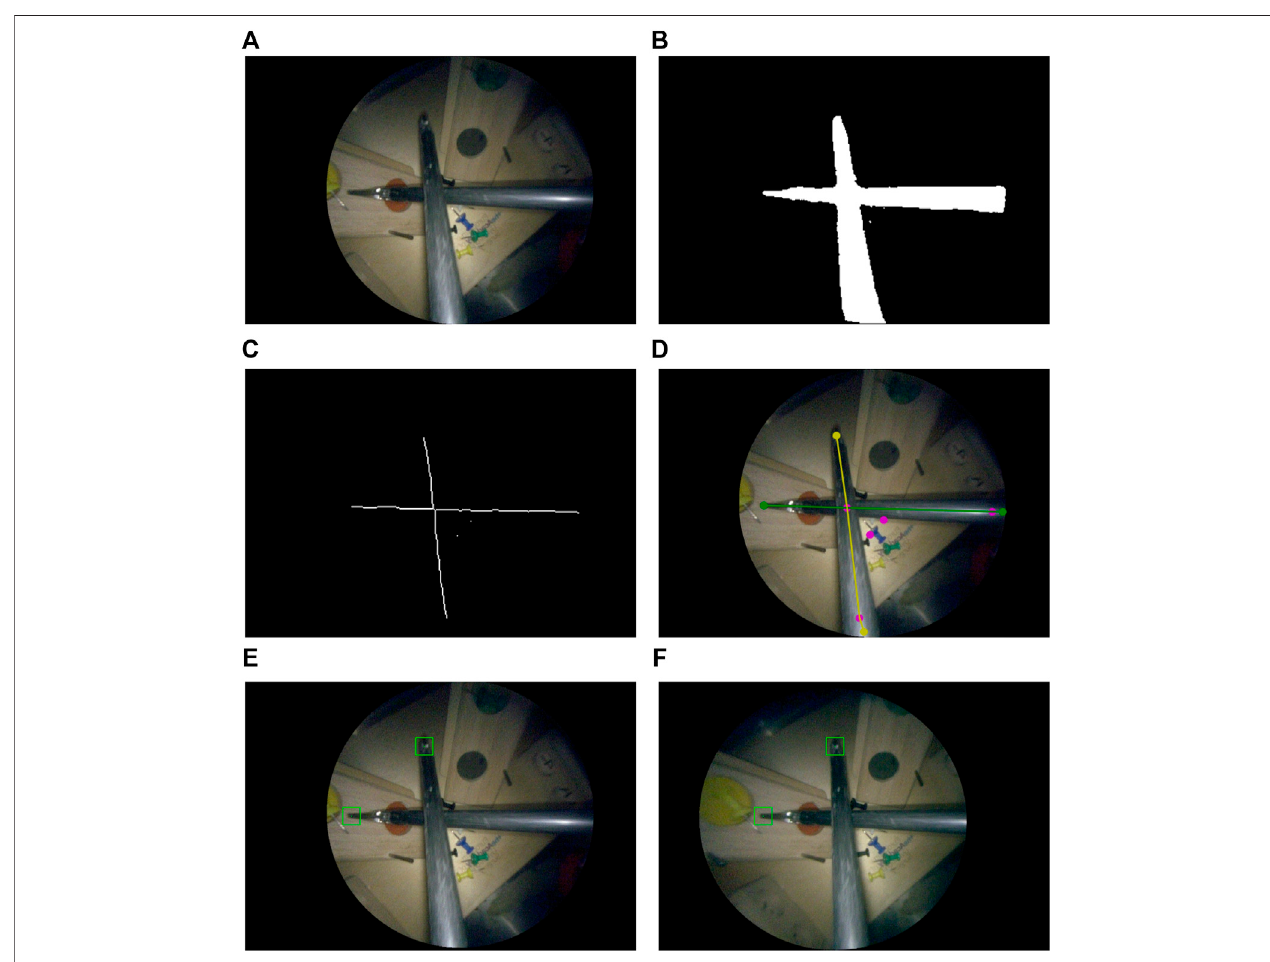
FIGURE 3 | Instrument localization pipeline: (A) stereo-recti fi ed right camera input image; (B) predicted tool segmentation; (C) skeletonisation; (D) graph extraction,2Ddetectionofentrypointsandtips,rightandleftinstrumentlabelledingreenandyellow; (E) leftand (F) rightstereo-matchedtooltipsin2D(bottomrow).The pink dots in (D) are graph nodes extracted from the skeleton in (C) but represent neither entrypoints nor tooltips.